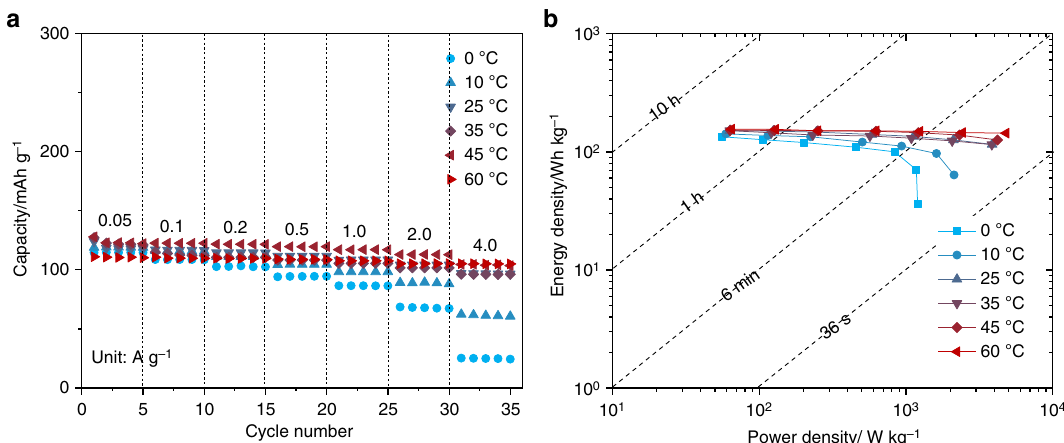
Fig. 5 High energy and power Na-ion full cells operating at a wide range of temperature. a Rate capacities. b Ragone plots of gravimetric energy densities versus power densities for graphite||Na 1.5 VPO 4.8 F 0.7 full cells in an optimal electrolyte at different